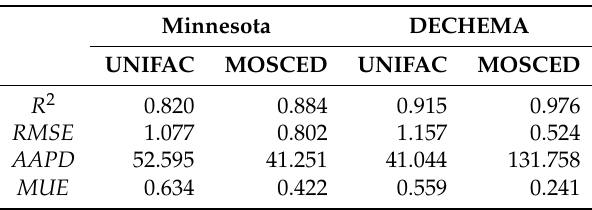
Table 6. A summary of the squared correlation coefficient ( R 2 ), root mean square error ( RMSE ), and mean unsigned error ( MUE ) for ln γ ∞ , and the average absolute percent deviation ( AAPD ) for i , j γ ∞ predicted using UNIFAC and MOSCED as compared to the reference data from the Minnesota i , j Solvation Database version 2012 [47] and DECHEMA [50–55].